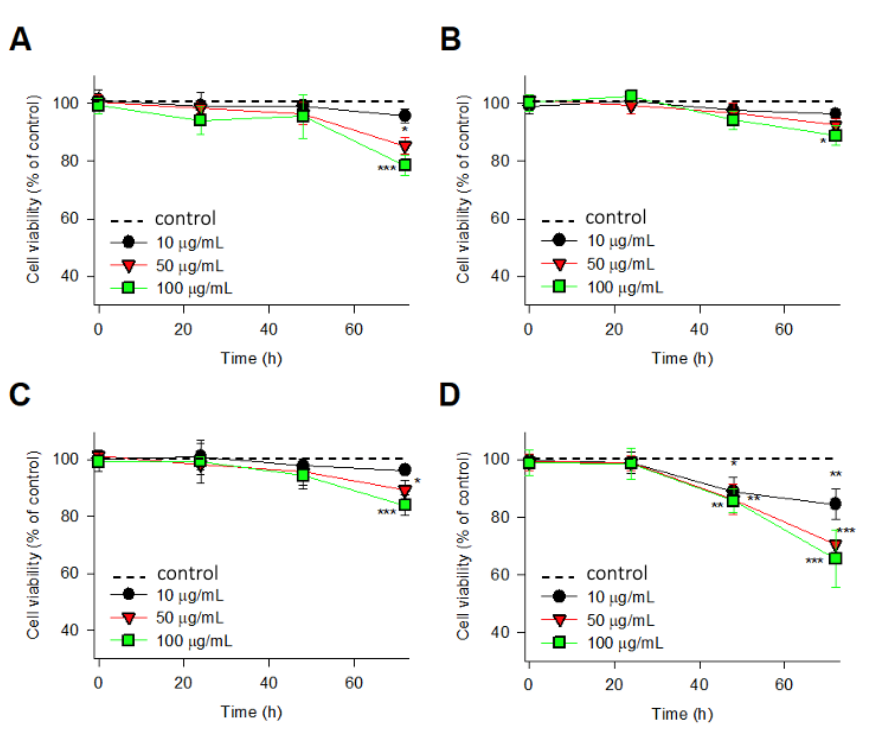
Figure 4. Cell viability of IMR-90 cells in the culture treated with 10, 50, and 100 µ g/mL of ( A ) LTL-R, ( B ) LTL-D, ( C ) MFI-S, and ( D ) FAU-S for 72 h. All data are represented as the mean ± SD compared to the control. Symbols *, **, and *** indicate the statistically significant difference with p values <0.05, <0.01, and <0.001,